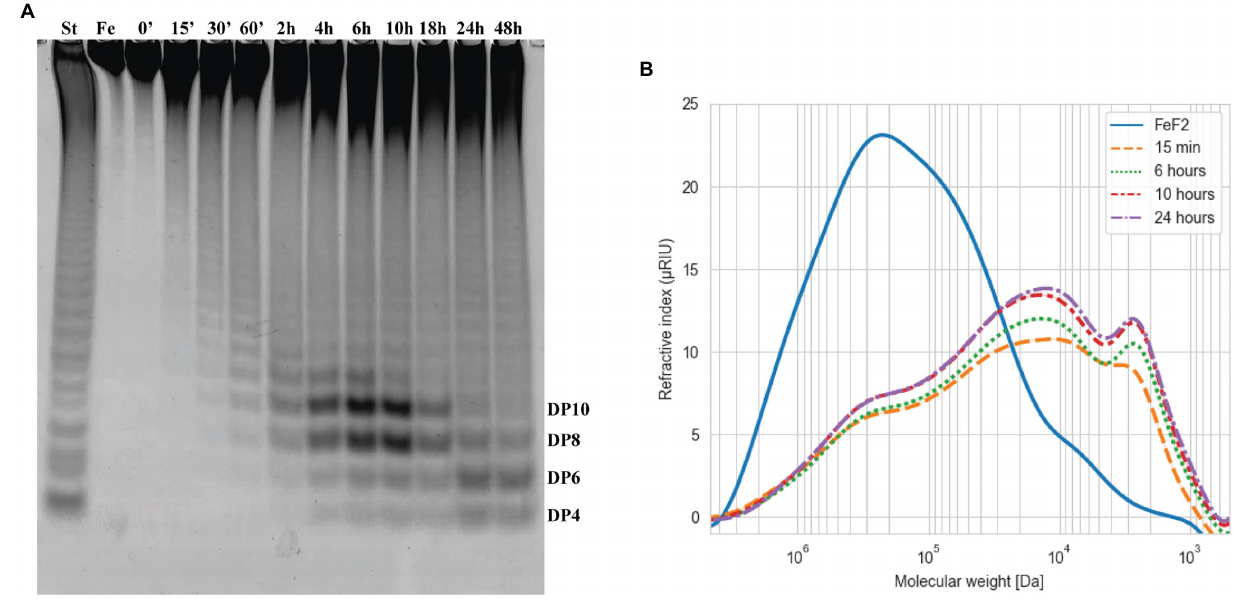
FIGURE 5 | Time course of Fhf2 ∆ 484 fucoidanase on fucoidan from F. evanescens . The Fhf2 ∆ 484 activity was measured at different time points during 0–48 h of reaction and visualized by (A) C-PAGE or (B) HPSEC. (FeF2) fucoidan substrate from F. evanescens , (St) positive control, reaction of FFA2 on F. evanescens fucoidan. Tentatively suggested oligosaccharide sizes are indicated (DP4-10). Reaction conditions were 0.9% substrate, 0.3 mg/ml enzyme, 10 mM Tris-HCl pH 7.4, 125 mM NaCl at 35 ° C for varying reaction times. HPSEC data are shown in logarithmic scale and the molecular weight is in